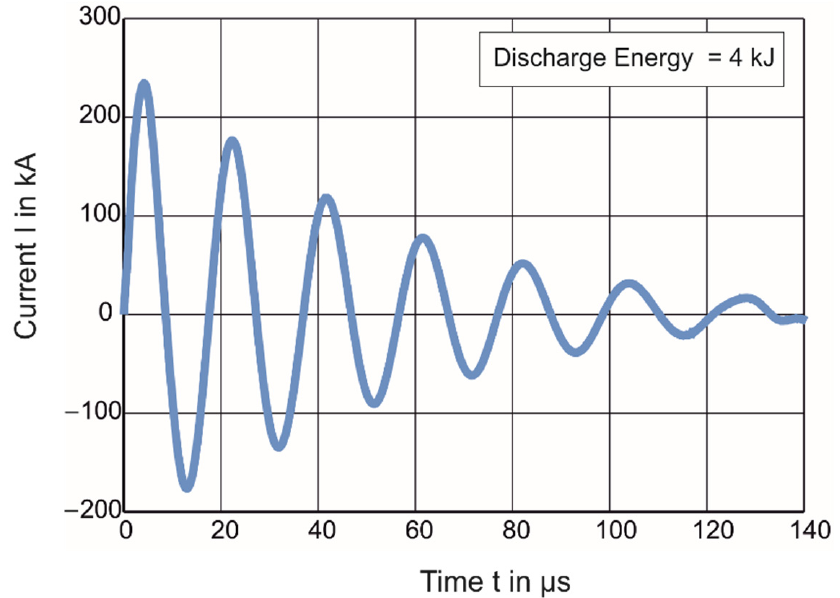
Figure 3. Input current curve for the simulations obtained for a discharge energy E 0 of 4 kJ. This current is distributed in both coils.